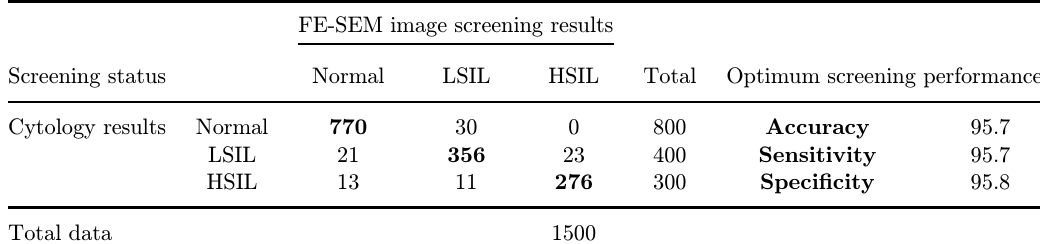
Table 2. Confusion Matrix and optimum screening performance of DA classi¯cation result for FE-SEM image texture features with comparing to cytology result.